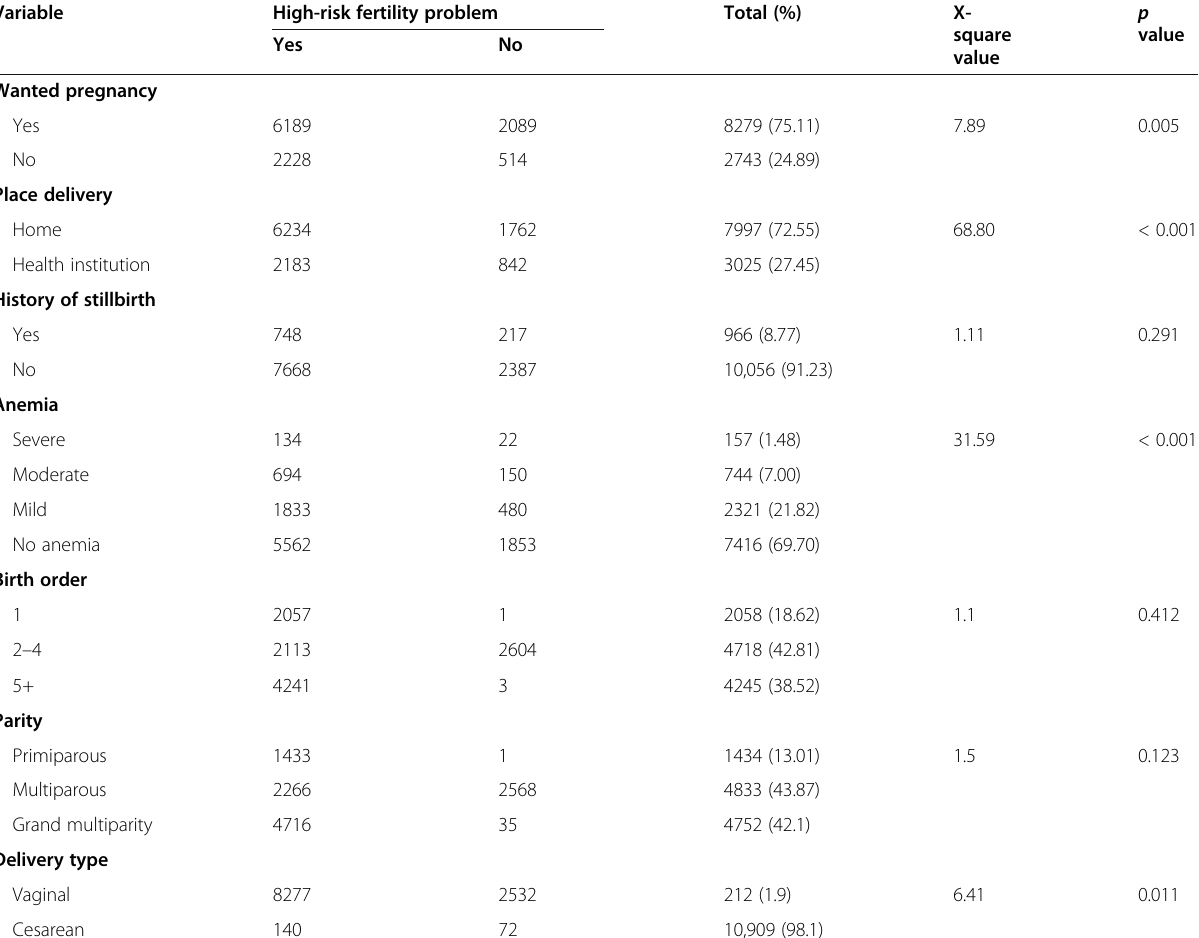
Table 2 Reproductive and high-risk fertility behavior of women who gave birth 5 years before the survey in Ethiopia, 2016 ( n = 11,022) High-risk fertility